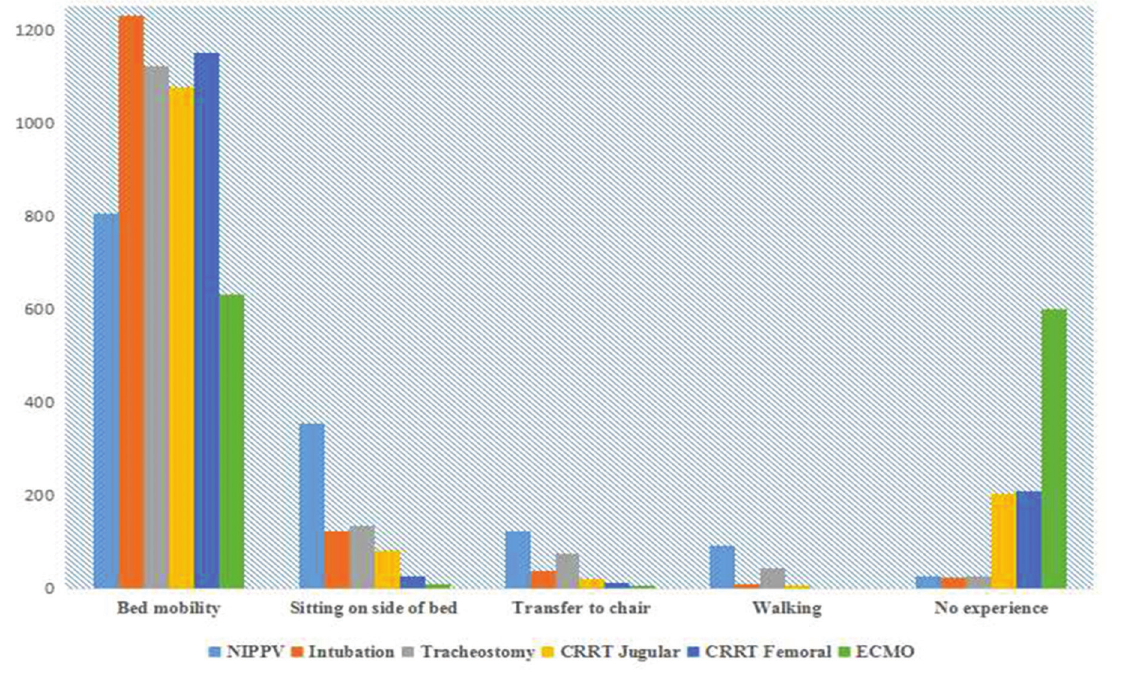
Figure 2. EM level during patient-specific treatments ( n =1,353). Abbreviations: EM, early mobility; NIPPV, noninvasive mechanical ventilation; CRRT, continuous renal replacement therapy; ECMO, extracorporeal membrane